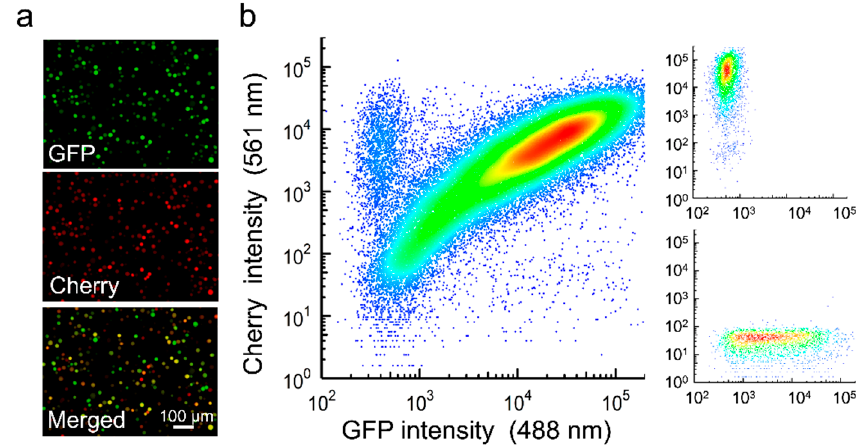
Figure 1. Coinfection of Sf21 cells with GFP- and Cherry-expressing AcMNPV. Cells were inoculated at an MOI of 5 PFU/cell and analyzed at 40 hpi. ( a ). Fluorescence microscopy. ( b ). Flow cytometry. Small panels on the right show monoinfected controls.